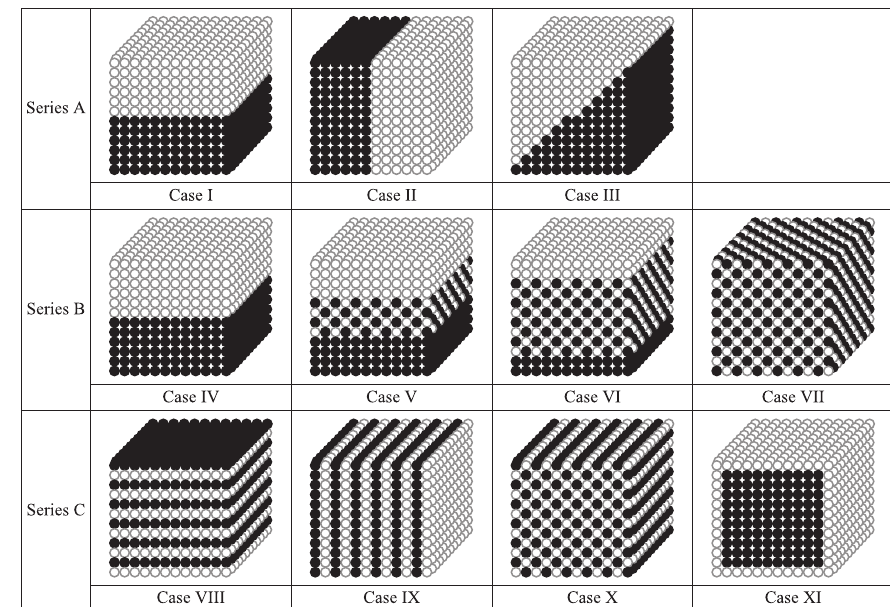
Fig. 5 Schematic representation of the configurations of black-white particles for different pre-arranged cases.